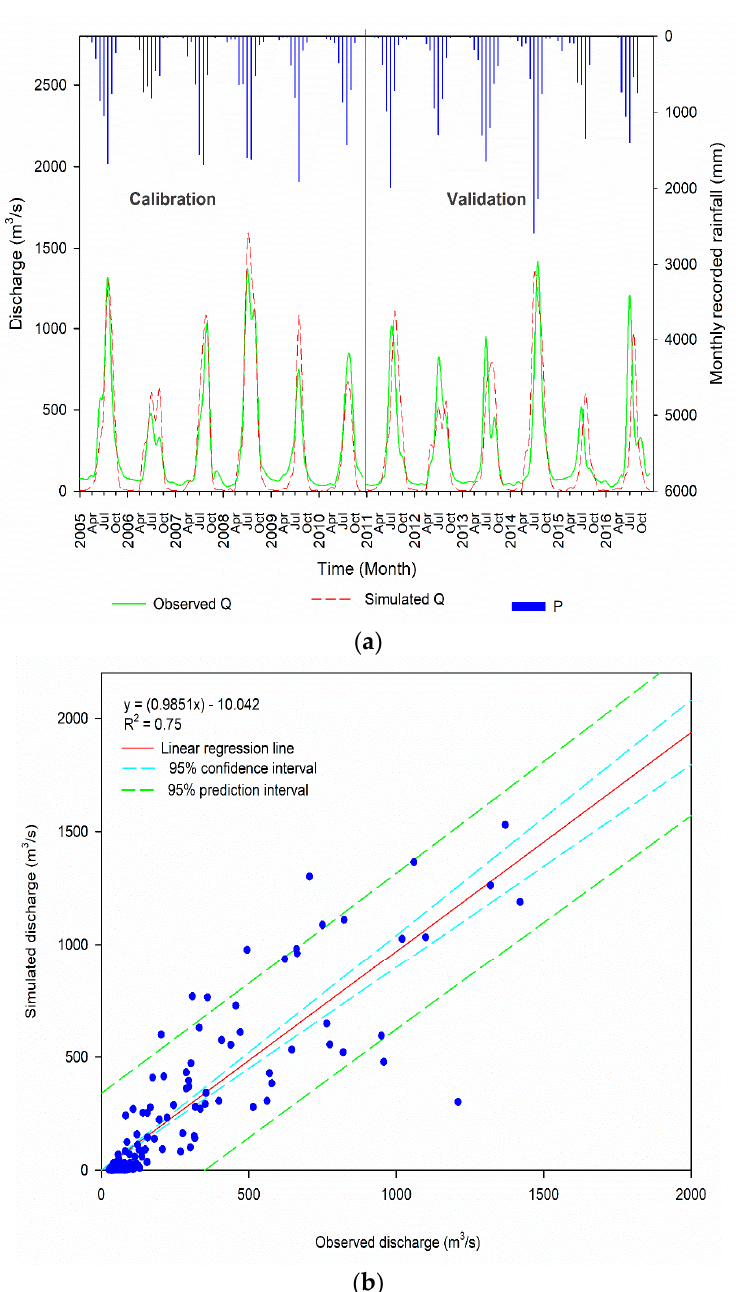
Figure 6. ( a ) SWAT simulation of Lhasa River discharge recorded at the Lhasa hydrometric station for time span of 2005–2016. ( b ) Comparison of observed and SWAT-simulated Lhasa River discharge from 2005 to 2016. Table 4. Performance of the SWAT model in simulation of Lhasa River flow under reservoir oper- ations. p-factor: percentage of data that is enclosed by the 95PPU band; r-factor: the average width of the 95PPU band divided by the standard deviation of the measured variable (from 0 to ∞ , with 0 showing perfect match).